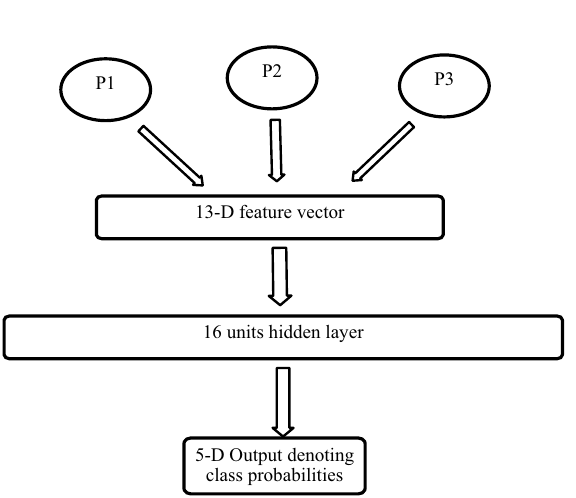
P2 is a 5-D vector